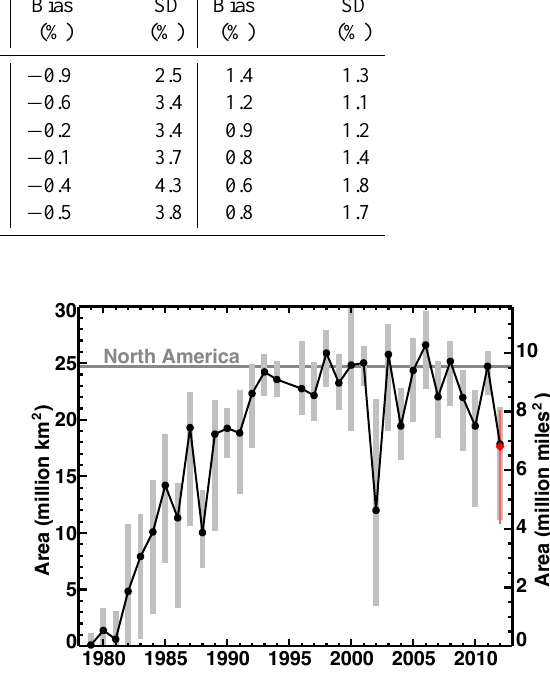
Fig. 4. Area of the Antarctic ozone hole from TOMS and OMI mea- surements (black circles), 1979–2012, and from OMPS (red circle) for 2012. These values are averaged from daily total ozone area values contained by the 220-DU contour for the 7 September–13 October period. The range of these daily total ozone area values are indicated for TOMS and OMI (gray shading) and OMPS (red shading in